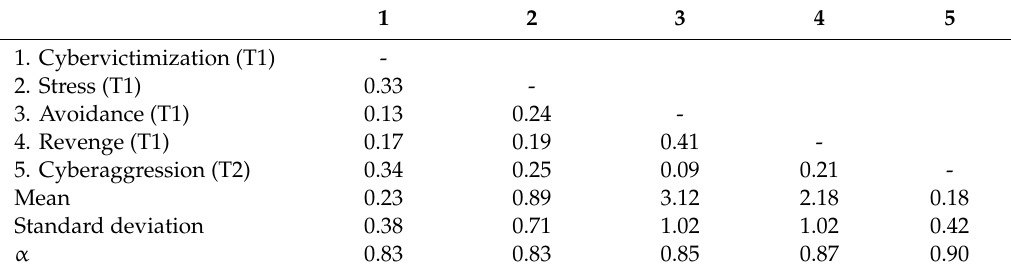
Table 1. Descriptive statistics, estimated internal consistency, and correlations among